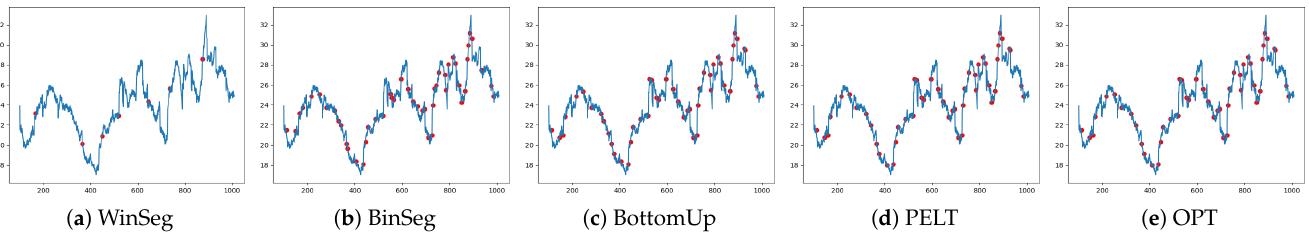
Figure 3. Change Point Detection (Note the line is the time series and the dot is the change